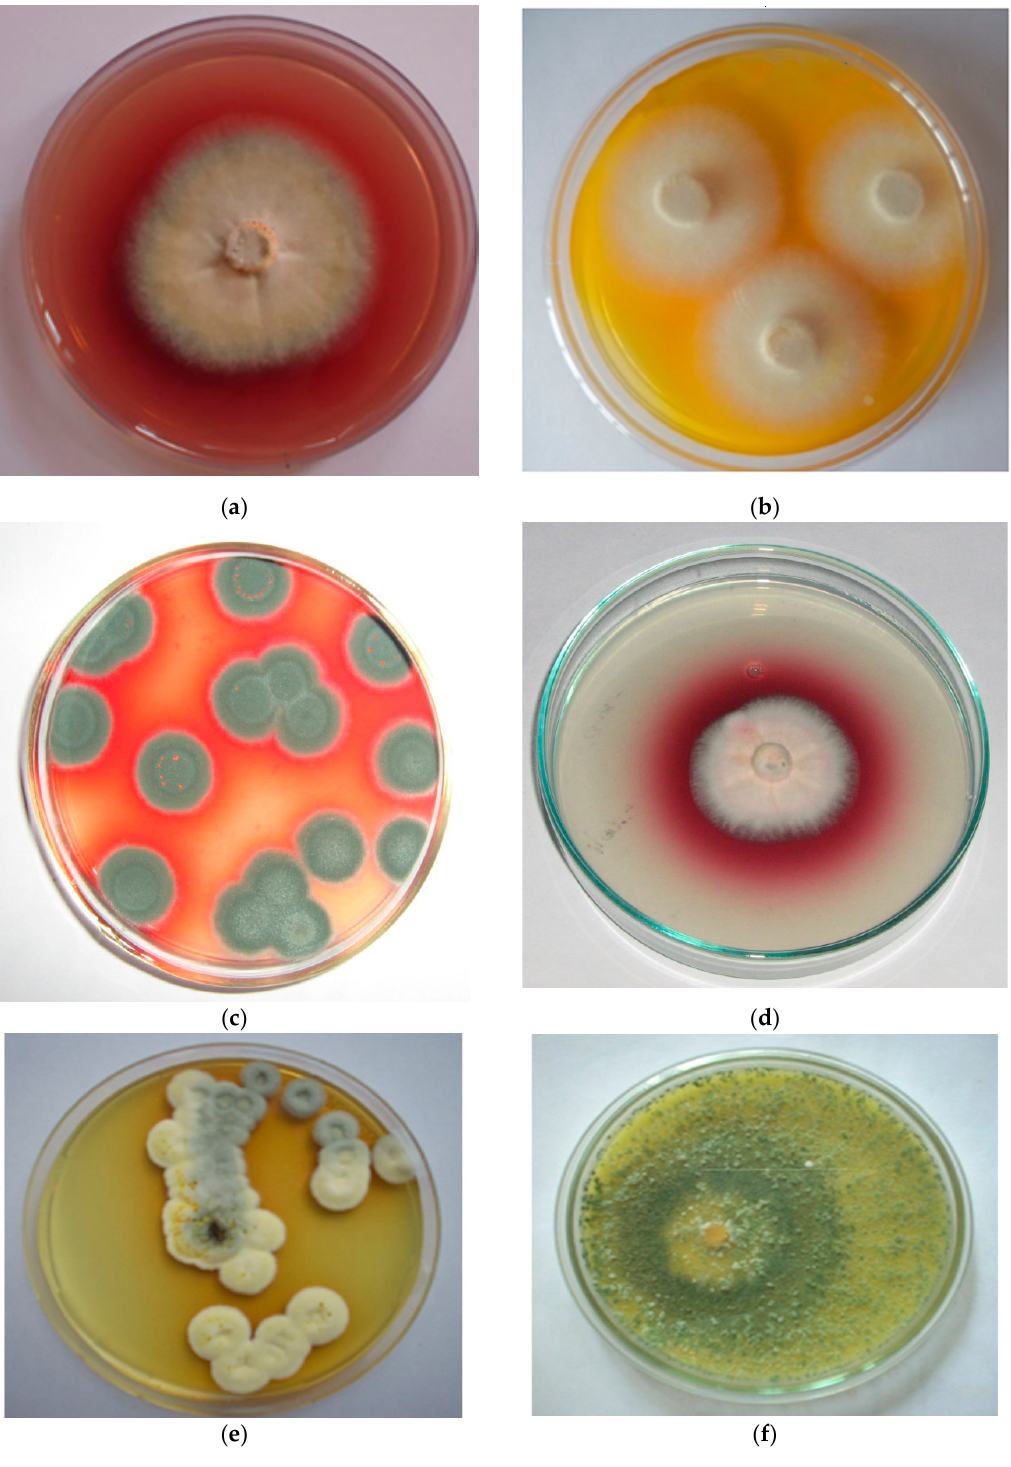
Figure 1. Pigments produced by different fungi: ( a ) Chaetomium sp. producing red pigment; ( b ) Thermomyces sp. pro- ducing yellow pigment; ( c ) Penicillium purpurogenum producing red pigment; ( d ) Fusarium sp. producing red pigment; ( e ) Penicillium purpurescens producing brown pigment ( f ) Trichoderma sp. producing yellow pigment.